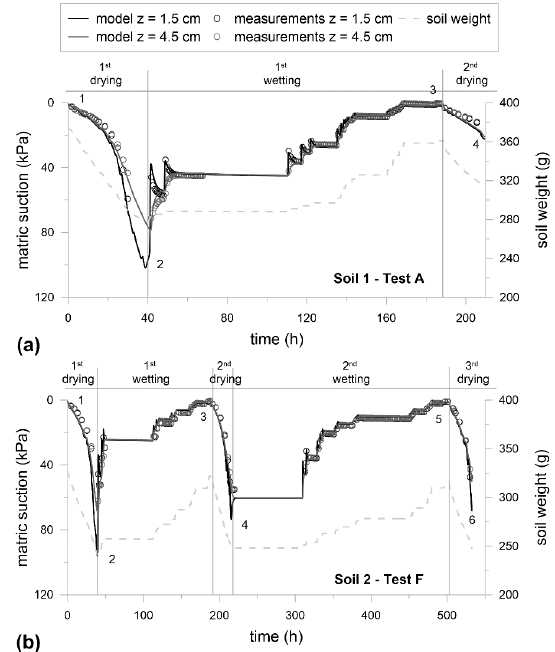
Figure 4. Results on soils 1 and 2 through laboratory tests (small scale). Experimental measurements of matric suction (symbols) at the top and bottom tensiometers compared to the calculated values (continuous lines) and soil weights measured over time for test A ( a ) and test F ( b ) in the ku-pF apparatus.